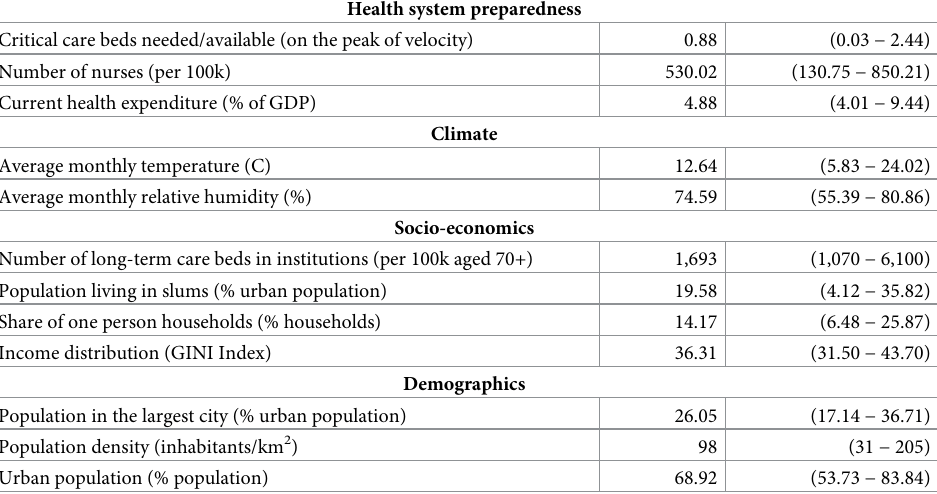
Table 2. Data on health system, climate, socioeconomics and demographics. For each item it is shown, at the peak of velocity on the country, the median followed by first and third quartiles (calculated over the 211 countries consid- ered in the study).